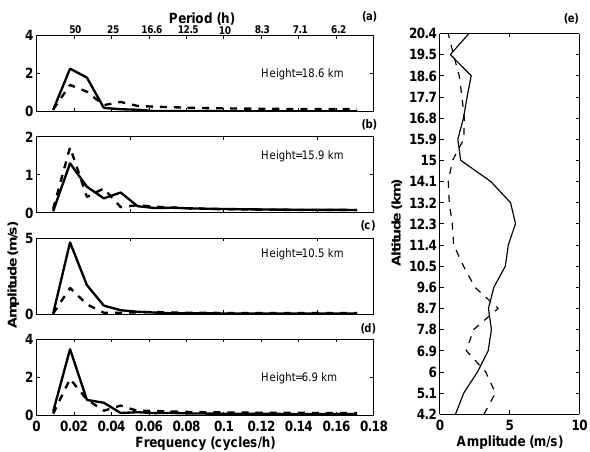
Fig. 7. Same as Fig. 4, but for long period (48–66h) wind fluctua-